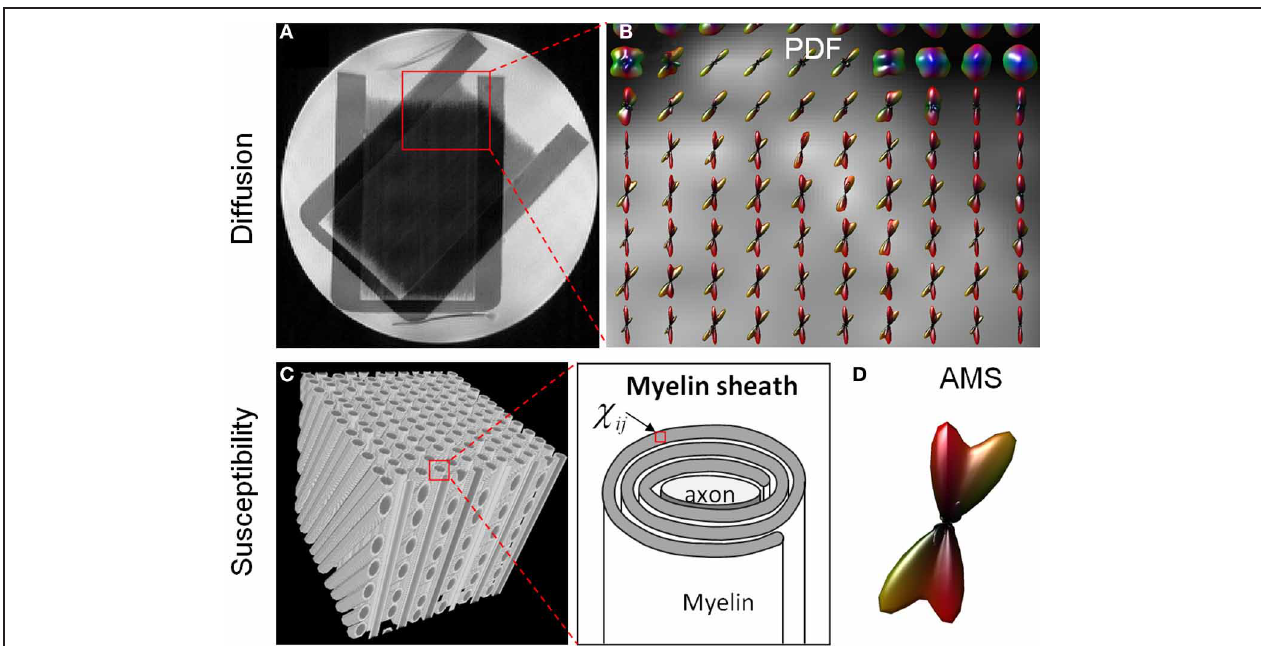
known phantom structure. (C) An illustration of myelinated axons crossing at 45 ◦ . Each voxel in the myelin sheath contained an anisotropic susceptibility tensor. (D) The distribution of AMS depicted a 45 ◦